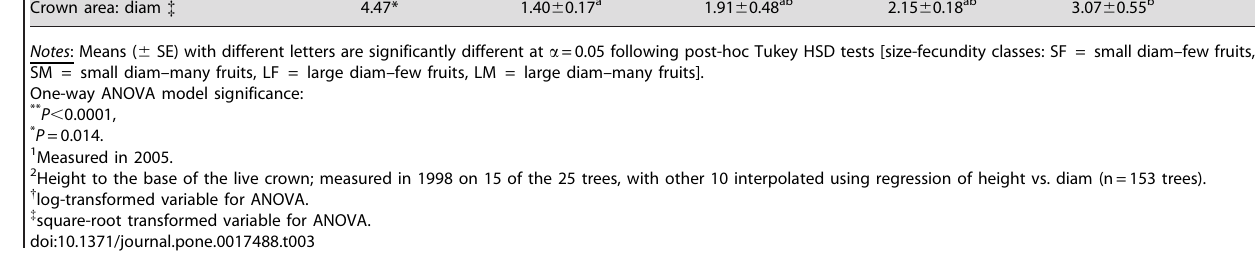
Total no. seeds found